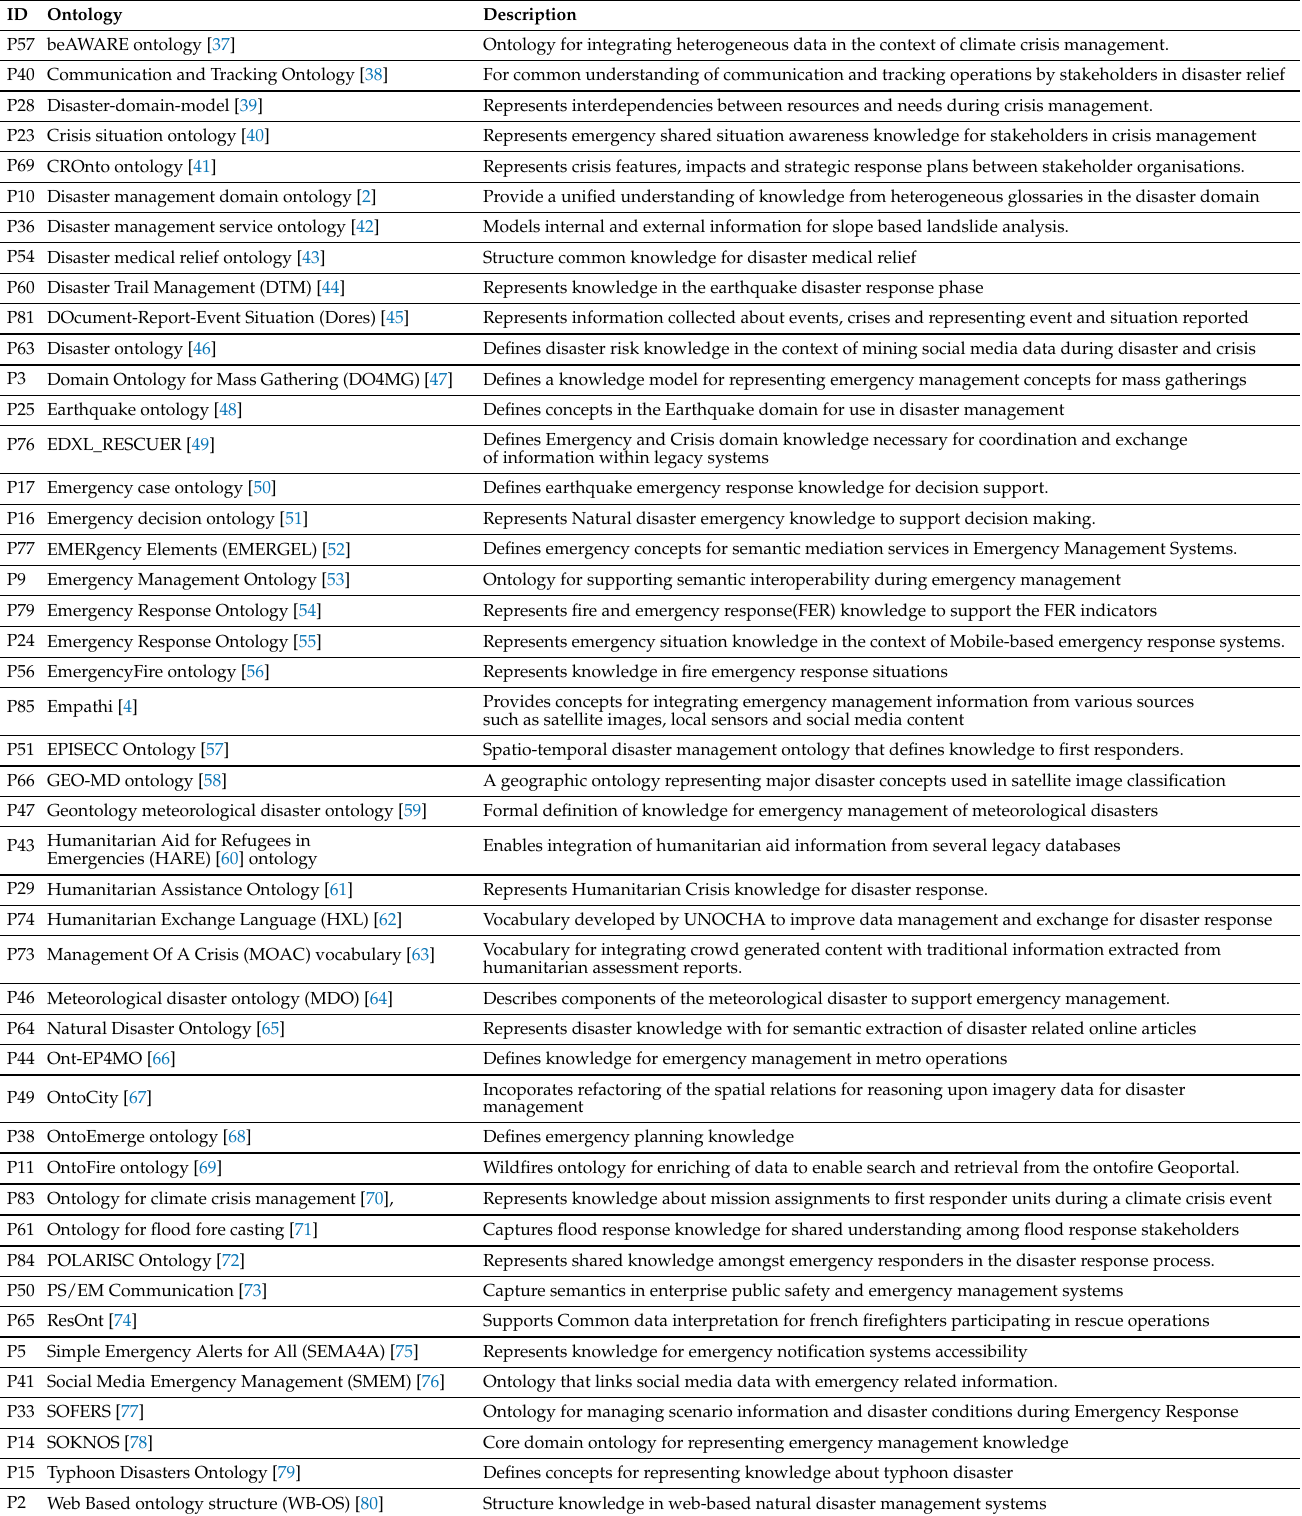
Table 4. Disaster Response Ontologies (Crisis and Humanitarian